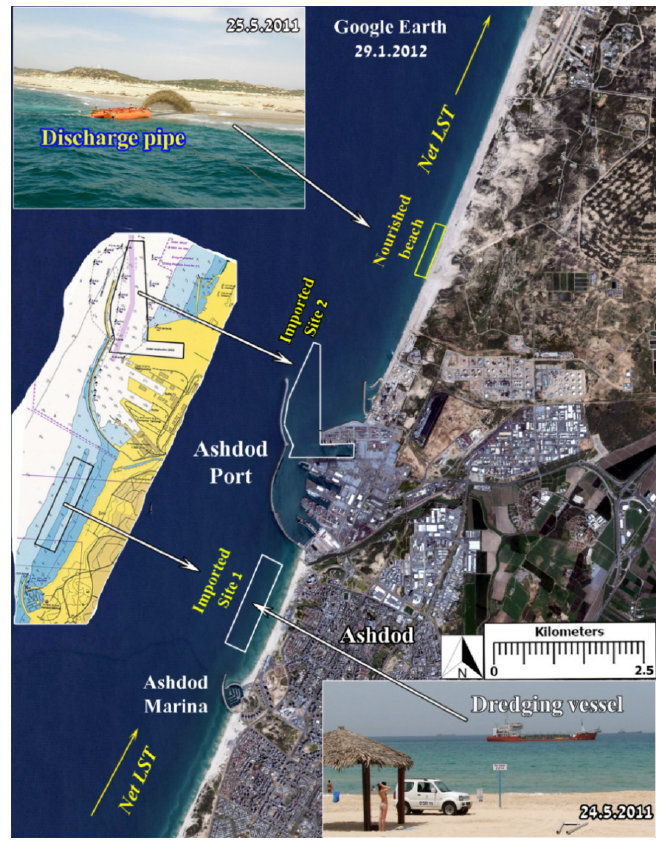
Figure 2. North of Ashdod Port sand beach nourishment project (May–August 2011). Dredging vessel operation (bottom inset); imported sand sites superimposed on local nautical chart (central inset); nourishment rainbowing operation via discharge pipe (top inset). Background: Google Earth image, 29 January